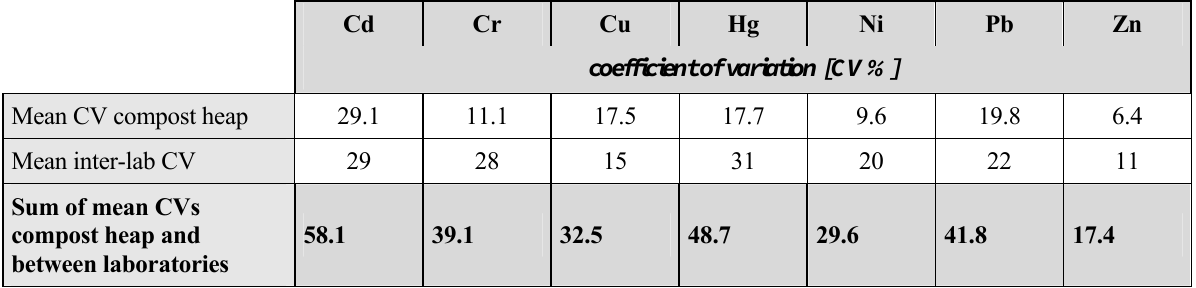
Table 12: Mean coefficients of variation resulting from the two main factors of variability: the inhomogeneity of a sampled compost batch and the deviation between individual laboratories. Cd Cr Cu Hg Ni Pb Zn coefficient of variation [CV